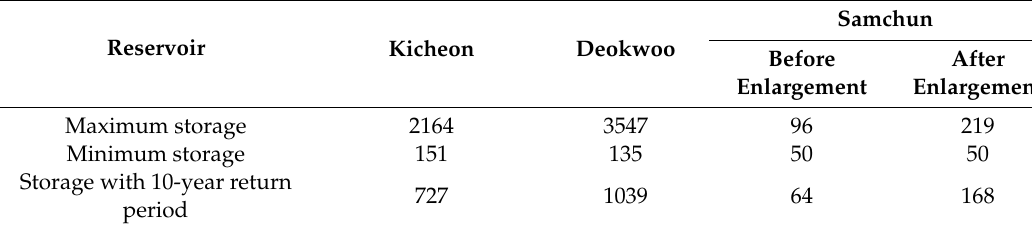
Figure 3. Study reservoirs. Table 1. Variables of agricultural reservoirs (values per 1000 m 3